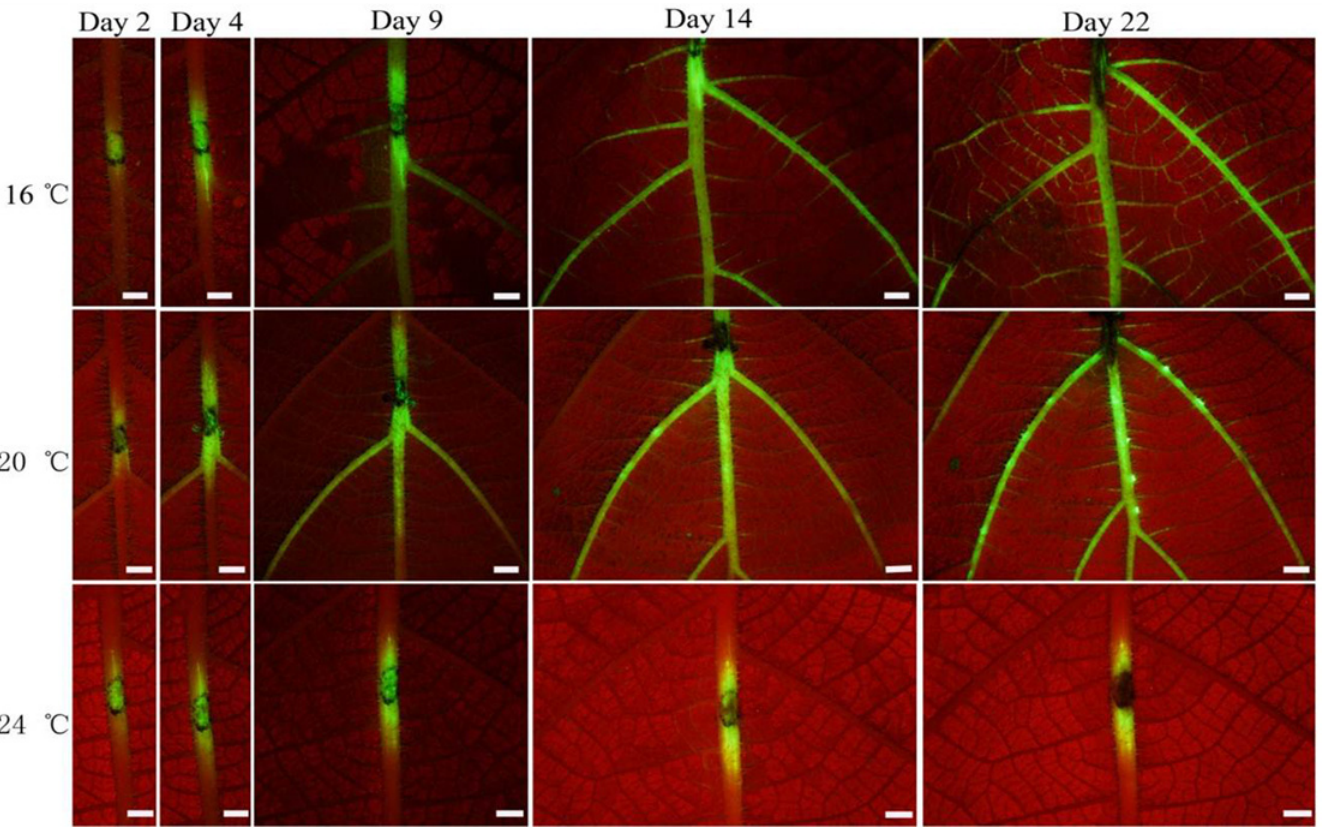
Fig 9. The GFPuv-labeled Psa colonization and migration in kiwifruit leaf veins. The inoculated leaves were observed under a fluorescence stereomicroscope (Leica MZ12) at different days after inoculation. Bar = 2